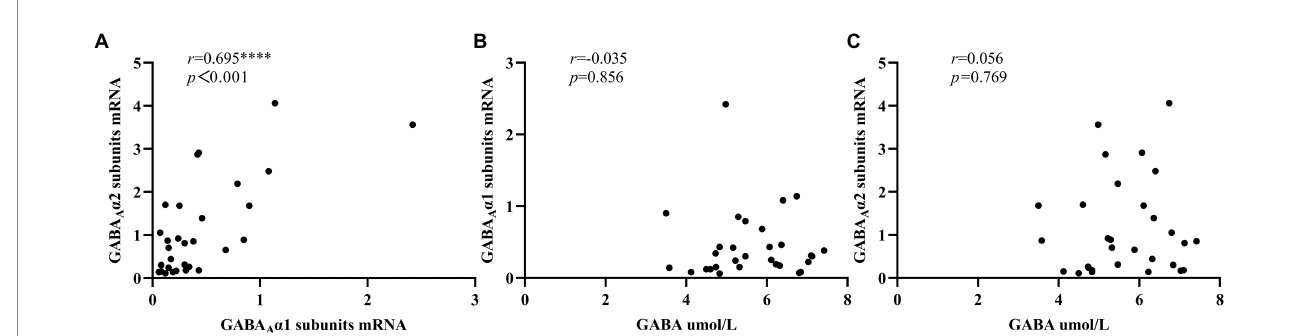
FIGURE 2 Correlation analysis of serum GABA level, GABA A receptor α 1 subunits mRNA and GABA A receptor α 2 subunits mRNA expression levels in the insomnia disorder group. 2 – ∆∆ Ct was used to calculate the relative expression of GABA A receptor α 1 subunits mRNAs and GABA A receptor α 2 subunits mRNAs. **** p < 0.0001.